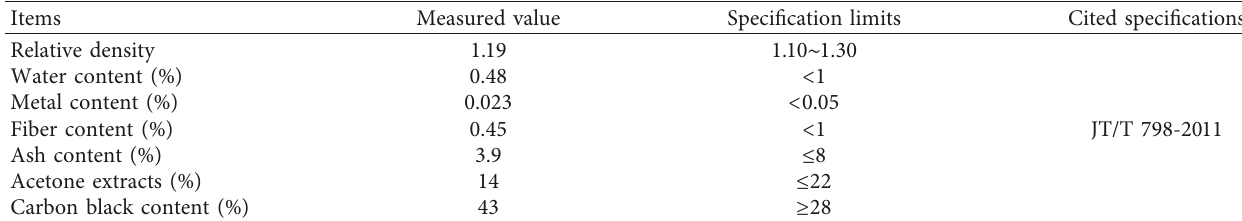
Table 2: Main technical indexes of rubber powder.